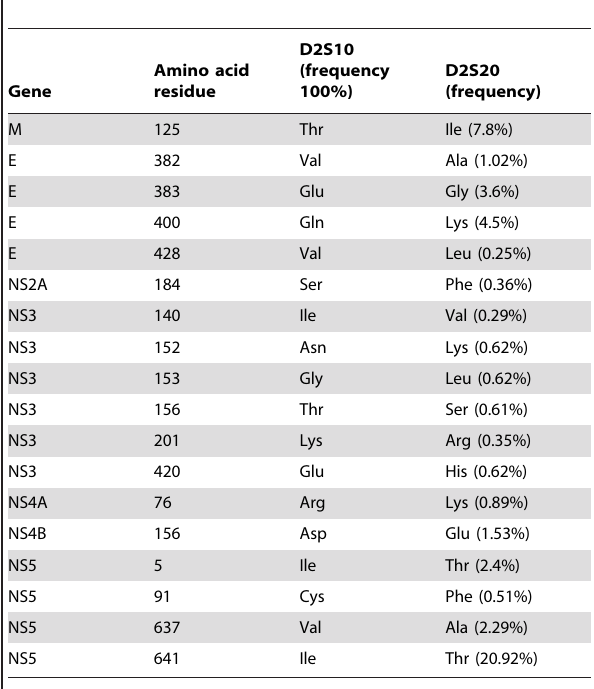
Table 2. Amino acid changes that are novel to DENV2 strain D2S20 relative to